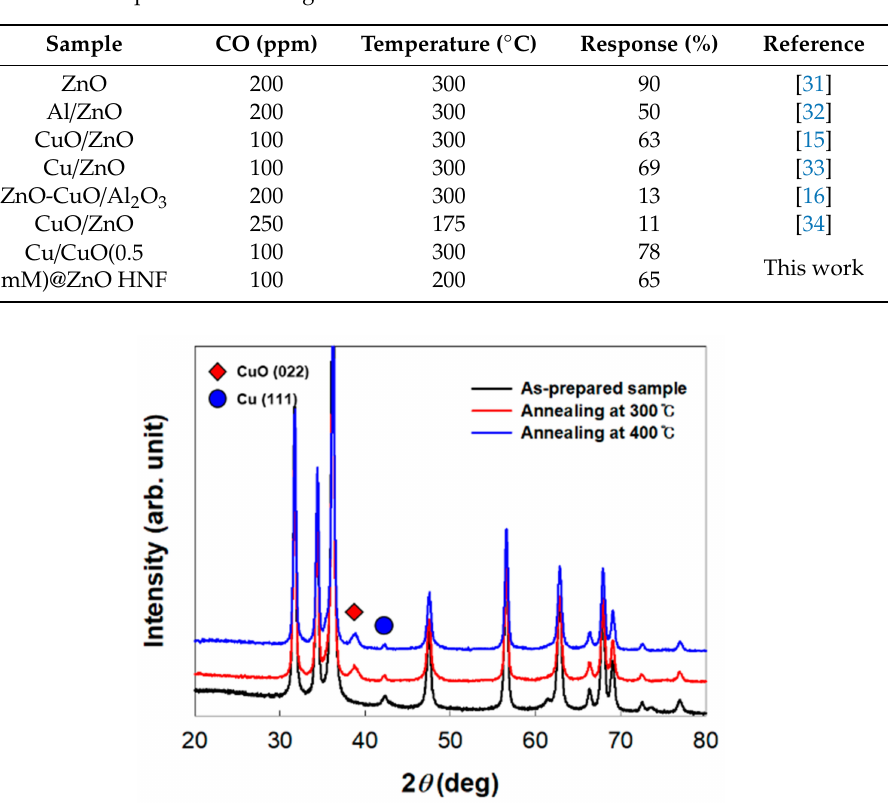
Figure 6. ( a ) CO gas-sensing (100 ppm) responses depending on temperatures of as-prepared Cu / CuO@ZnO HNFs; ( b ) repeatability test of Cu / CuO(0.5 mM)@ZnO HNF for CO gas in di ff erent working temperatures. Table 2. Comparison of sensing characteristics toward CO of some ZnO-based sensors.